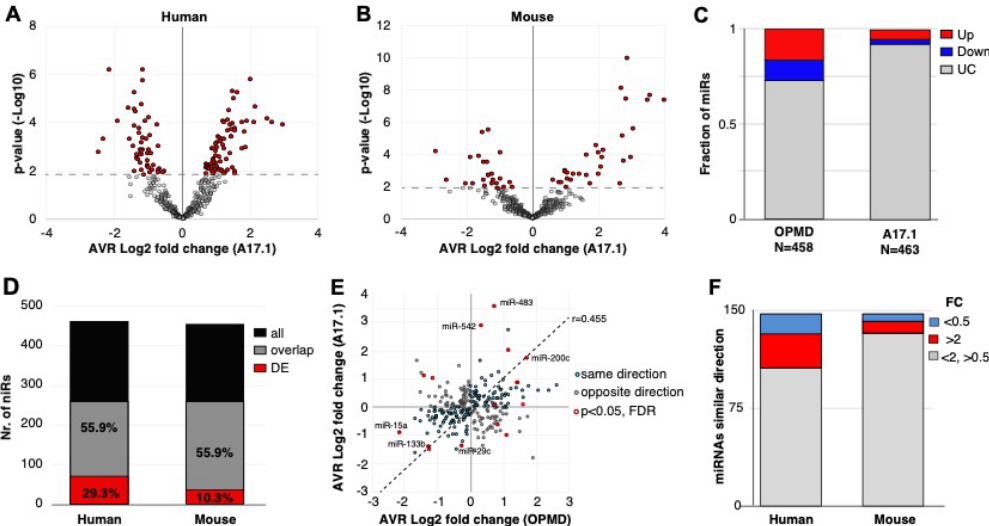
Figure 2. OPMD and A17.1 differentially expressed miRNAs. ( A ) and ( B ) Volcano plots show the average fold-change (log2) against p -value (-log10) in OPMD vastus lateralis (VL; A ) or in A17.1 mouse tibialis anterior (TA; B ). The miRNAs with pFDR < 0.05 are depicted in red. ( C ) Bar chart shows the fraction of deregulated miRNA in humans or mice. The upregulated miRNAs are depicted in red, and downregulated in blue. ( D ) Bar chart shows the number of total and overlapping miRNAs between mouse and human (depicted in black or grey, respectively). The proportion of overlapping miRNAs is from the total. The overlapping deregulated miRNAs are depicted in red, and the proportion of the deregulated miRNAs is from the overlapping miRNA pull. ( E ) Scatter plot of the average fold-change of the 252-overlapping miRNA. Pearson correlation coefficient (r) and regression line are depicted. Similar fold-change directions between human and mouse are depicted in cyan and the miRNA with opposite direction are in grey. The overlapping miRNAs with pFDR < 0.05 are encircled in red. The miRNAs with the highest or lowest fold-changes in both humans and mice are indicated. ( F ) Bar chart of the overlapping miRNAs with a similar fold-change direction in mouse and human. The number of miRNAs with a fold-change (FC) > 2 or < 0.5 are depicted in red and blue, respectively.